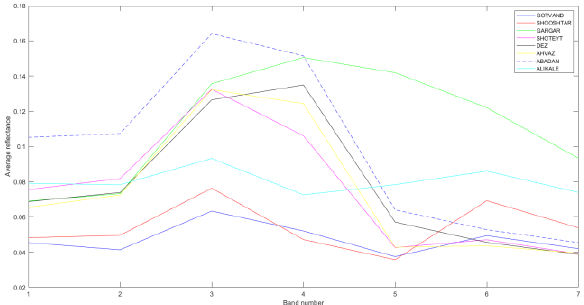
Figure 1. The study area and location of 8 EC sampling station (southwest of Iran) (Karamouz et al., 2009; Keshavarzi et al.,